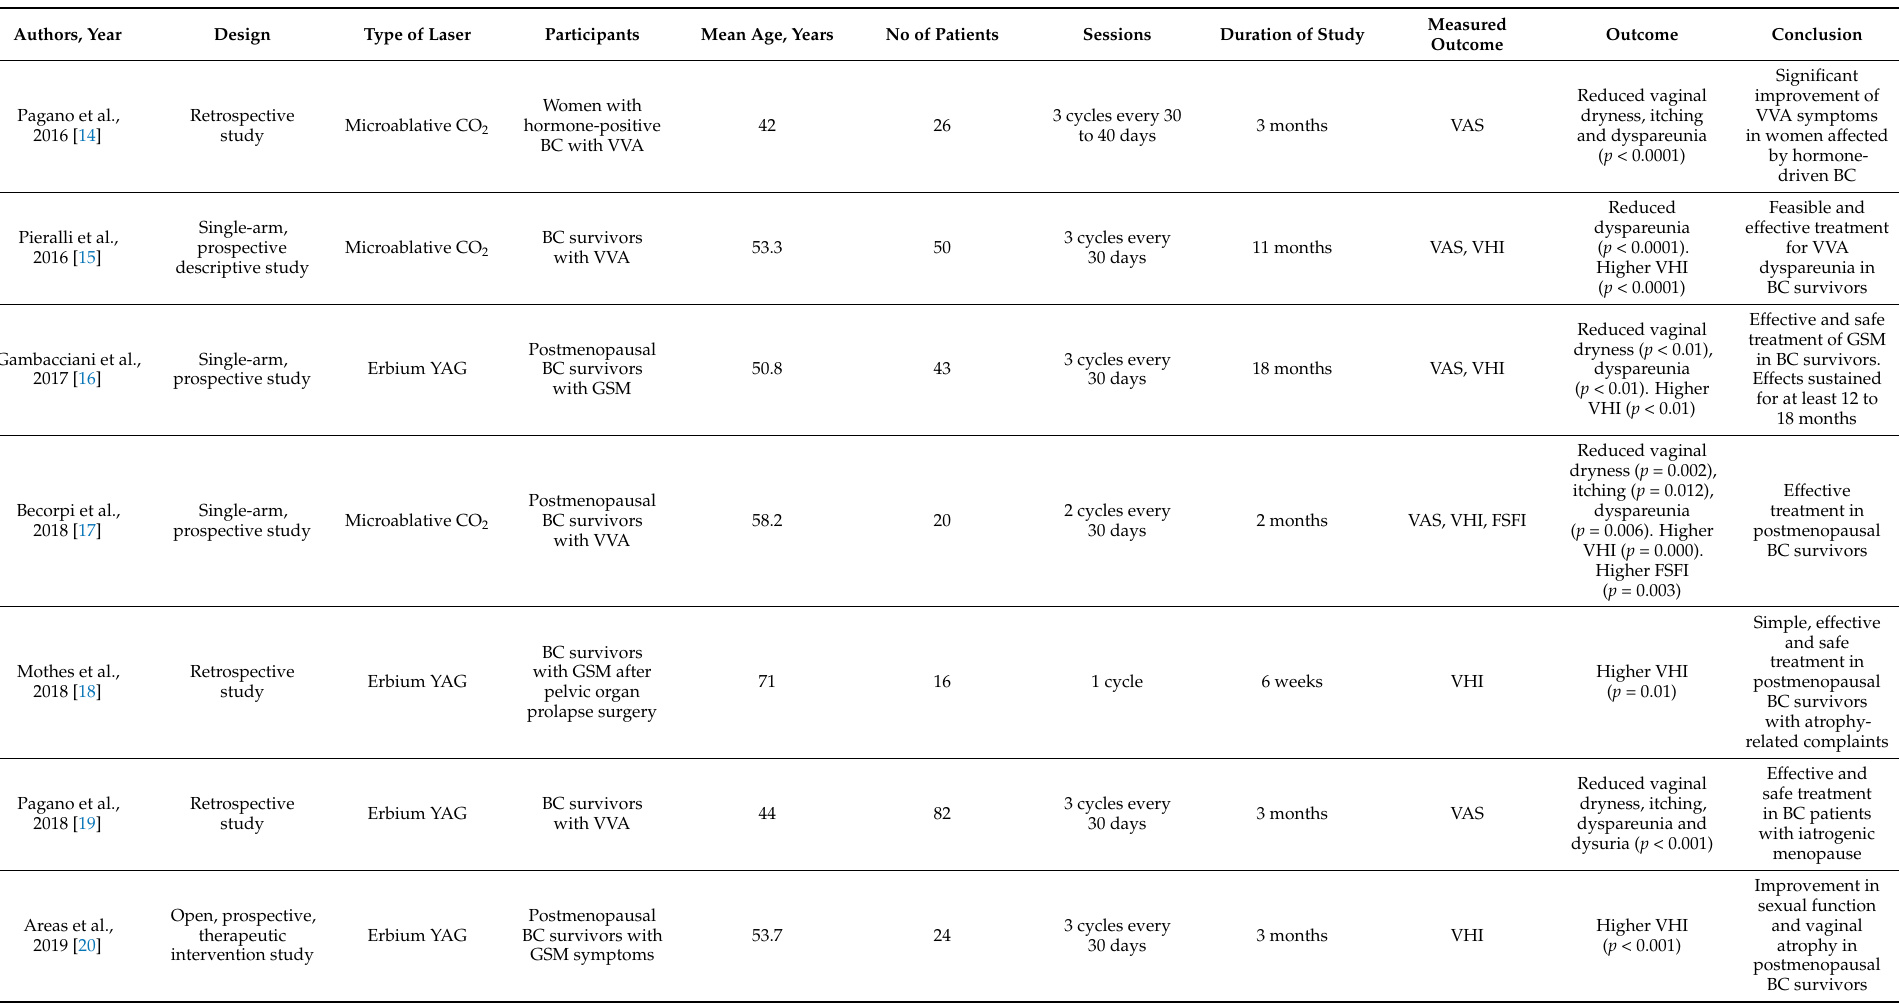
Table 1. Results of the studies of laser therapy for GSM in BC